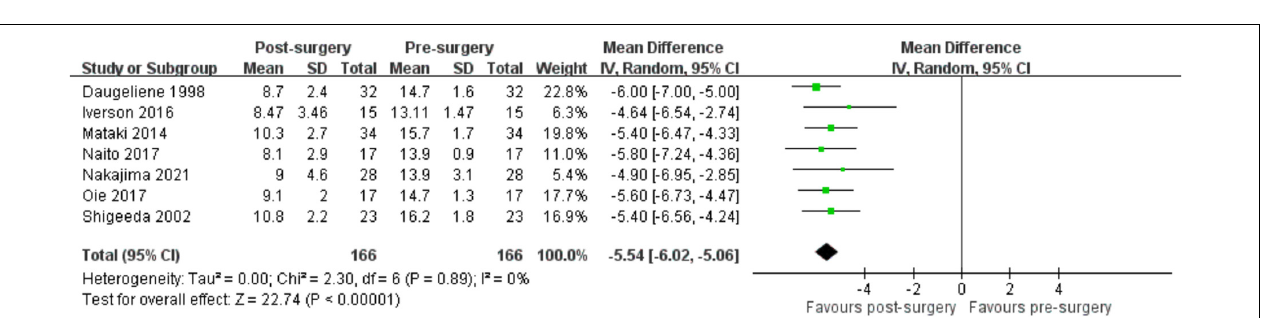
FIGURE 4 | Mean change in IOP in patients with NTG before and after